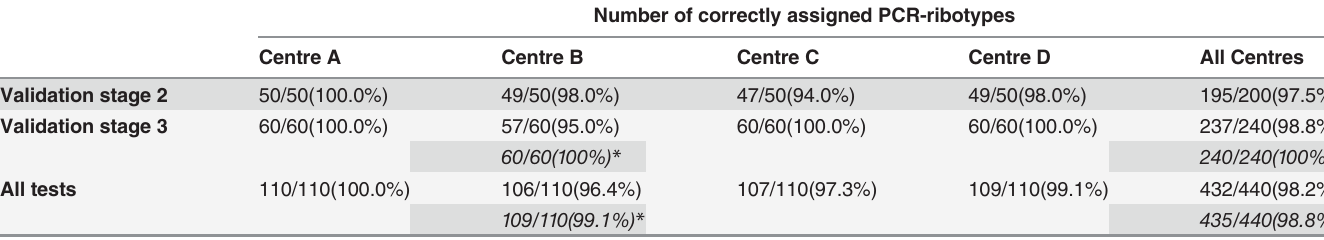
validation stage 3 and the overall study to 240/240 (100%) and 435/440 (98.9%)